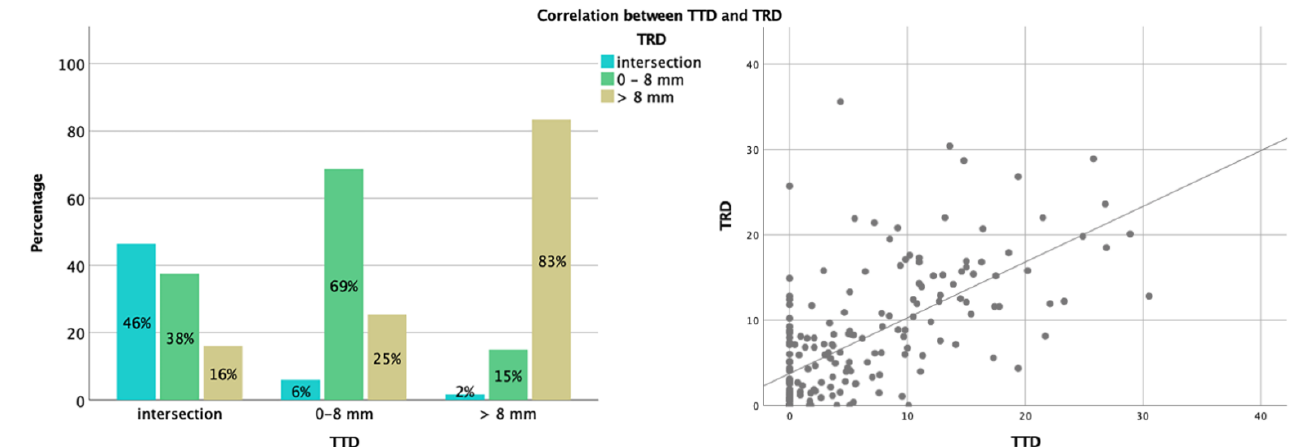
Figure 2. Correlation between the TTD and the TRD. The figure shows a bar chart for TRD according to TTD categories (8 mm cutoff and intersection) on the left side. On the right side, the scatter plot shows the correlation between TTD and TRD as continuous variables.